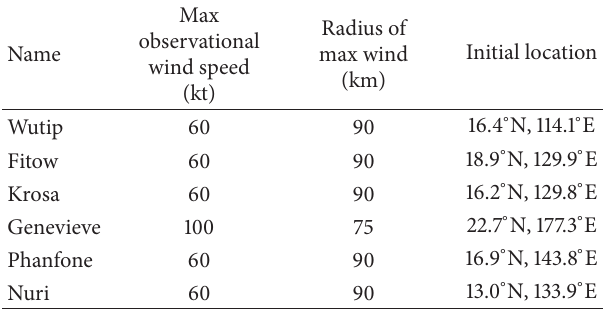
Table 4: Averaged terms and improvements of track, CSLP, and MWSP by the vortex initialization scheme.